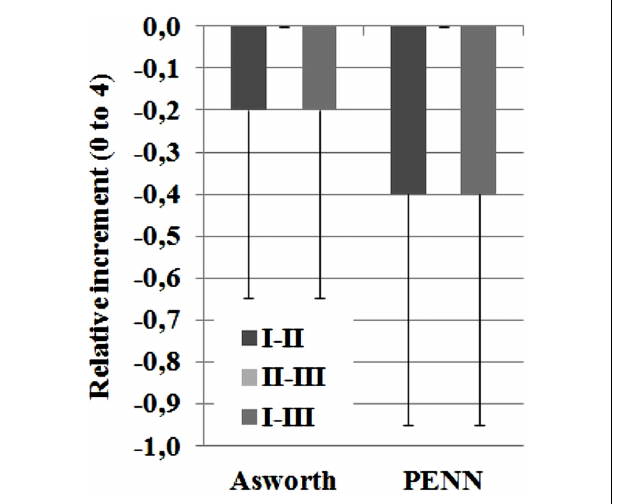
FIGURE 8 | Results for spasticityASHWORTH and PENN scales. Score can range from 0 to 4.The reported data are median and range.